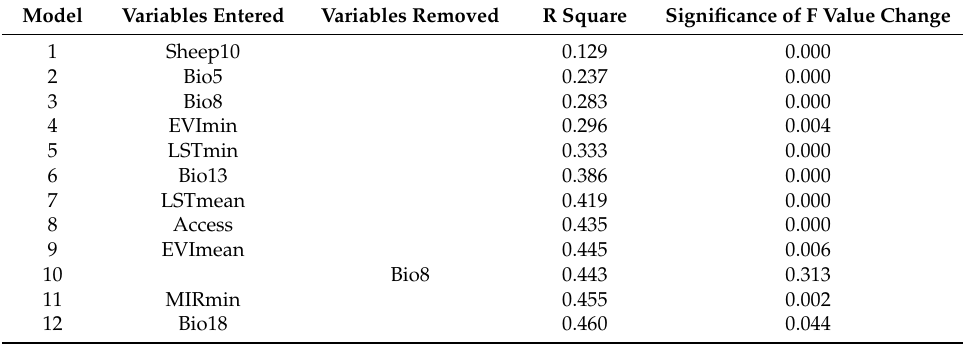
Table 1. Summary of the stepwise regression analysis of environmental factors affecting the annual incidence of HB in counties of Inner Mongolia (note: the variables were entered if p ≤ 0.05, and removed if p ≥ 0.10).